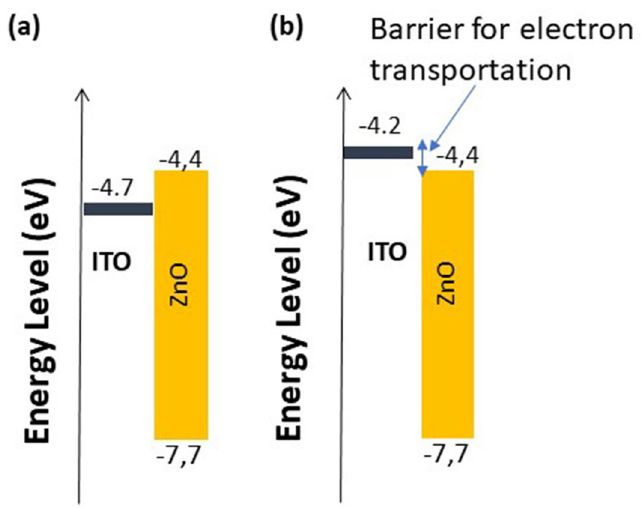
Figure 14. Effect of illumination on the position of Fermi level of